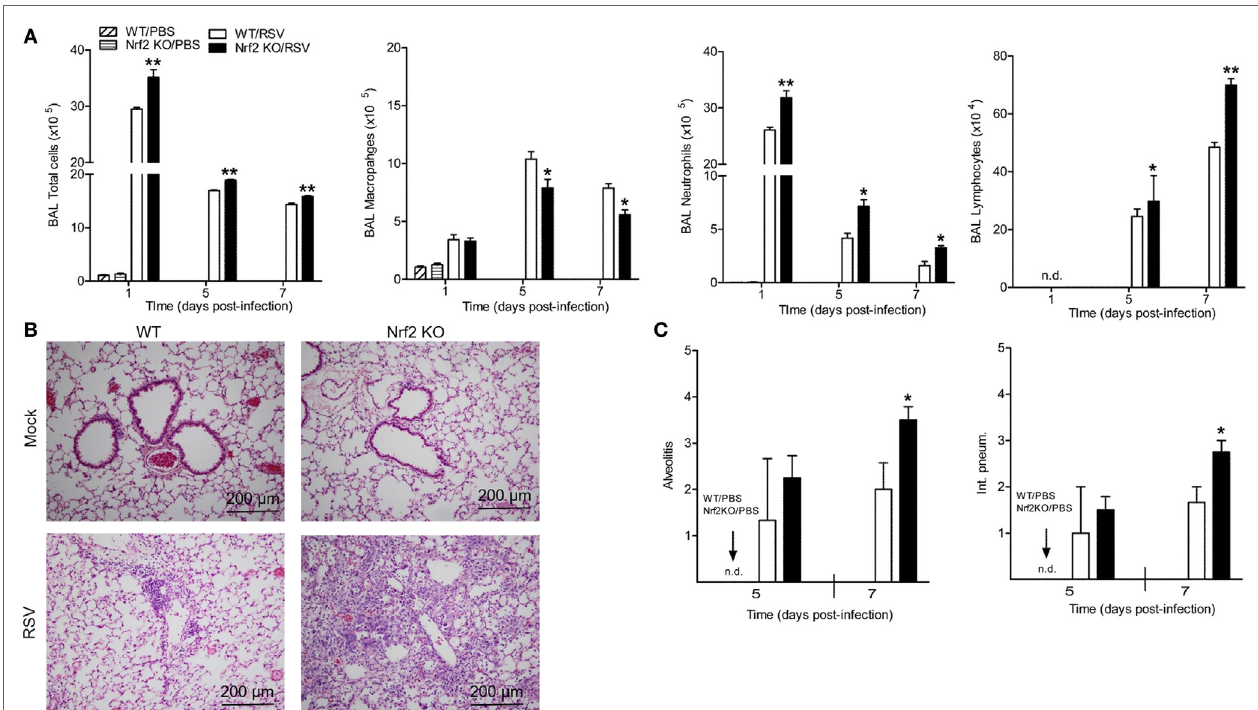
FigUre 3 | NF-E2-related factor 2 (Nrf2) gene deficiency increases airway neutrophilia and lung inflammation in respiratory syncytial virus (RSV)-infected mice. Nrf2 KO and Nrf2 wild type (WT) mice were infected with RSV or PBS. (a) Bronchoalveolar lavage was collected at different time points after infection for differential cell counts by Protocol HEMA3-stained cytospins. (B) Lung samples were harvested at days 5 and 7 post-infection, formalin-fixed for slide preparation, and hematoxylin and eosin stained. Representative stained lung tissue sections from the indicated treatment at day 7 post-infection. (c) Alveolitis and interstitial pneumonitis scored on lung sections. The bar graph represents mean ± SEM ( n = 2–4 mice/group). * p < 0.05, ** p < 0.01 when compared with WT/RSV